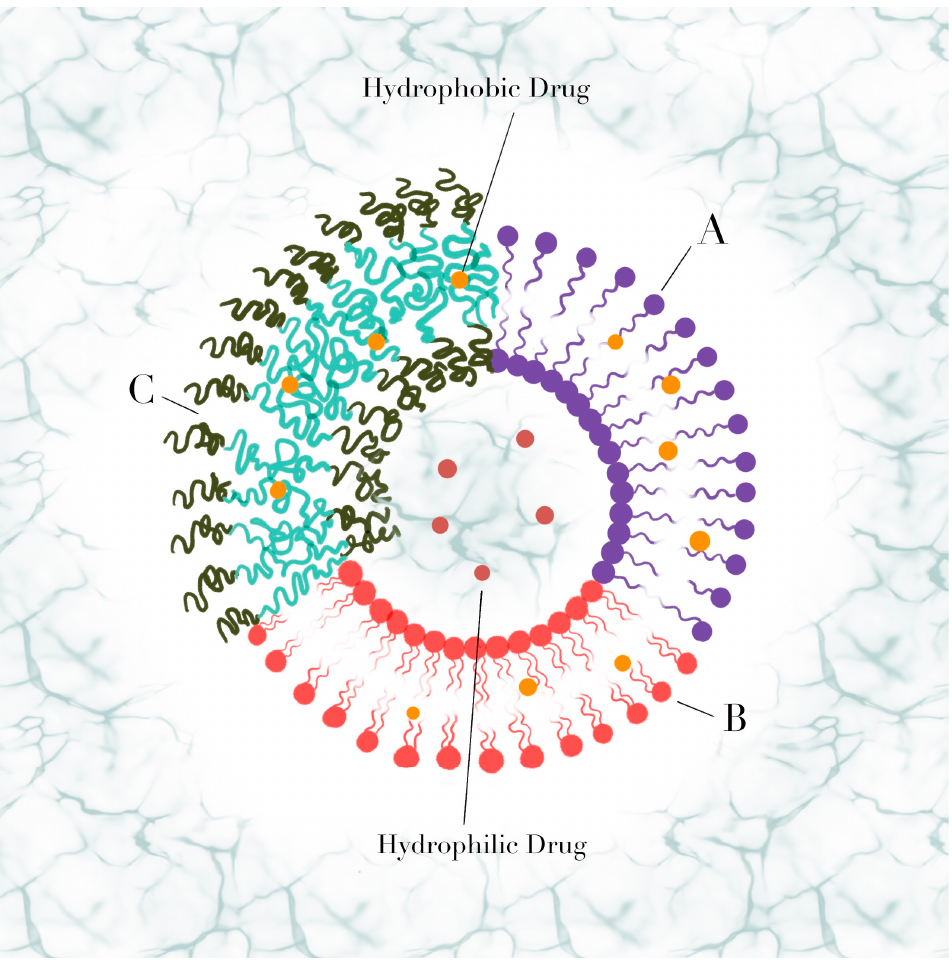
Figure 1. Comparative scheme of different vesicle structures: ( A ) niosomes; ( B ) liposomes; ( C ) polymersomes.